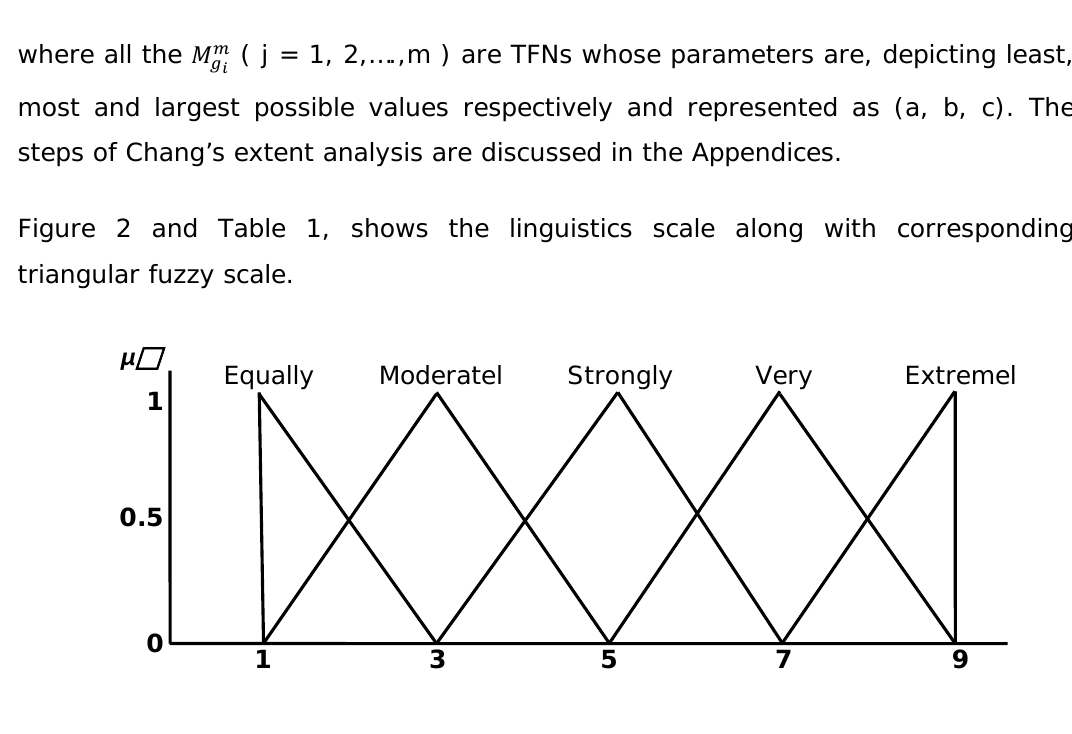
Figure 2. “Linguistic variables for the importance weight of each criterion”.